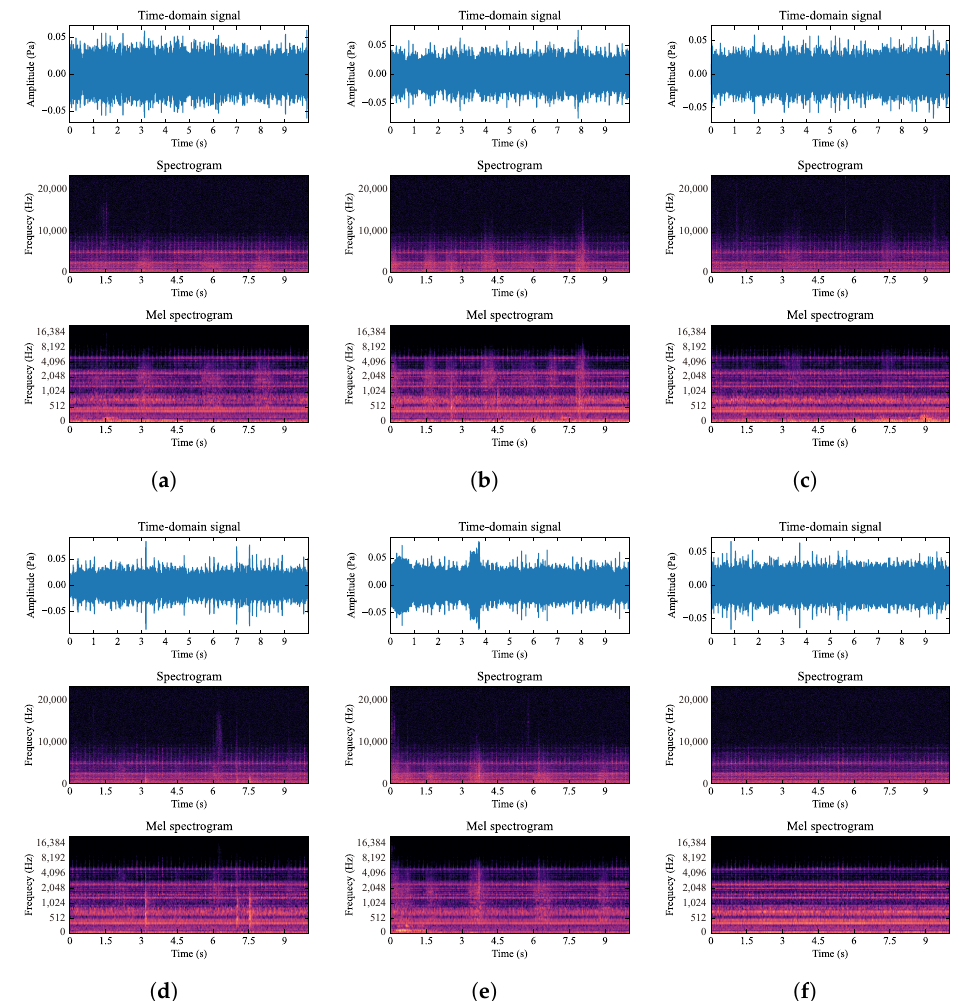
Figure 6. Signals of different FOD: ( a ) Nut, ( b ) Ti-wire (3.93 g), ( c ) Ti-wire (0.33 g), ( d ) Rivet, ( e ) Bolt, ( f ) Without FOD. In the spectrum and Mel spectrum, a brighter color means higher energy.